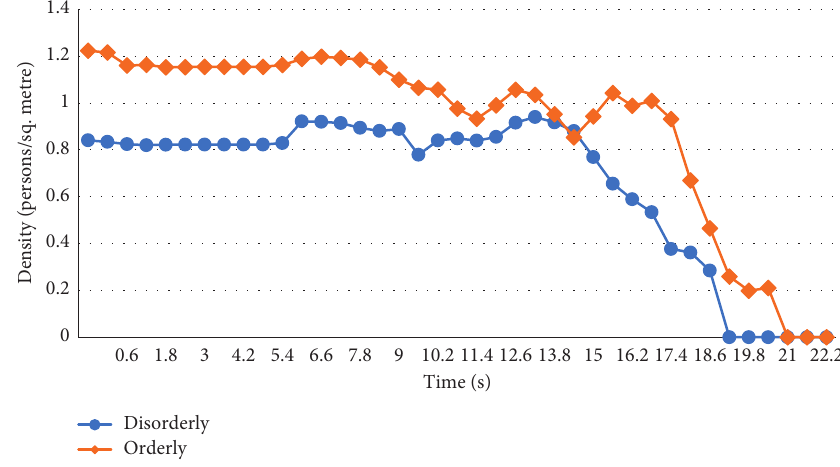
Figure 8: Local maximum density variation in the process of evacuation.